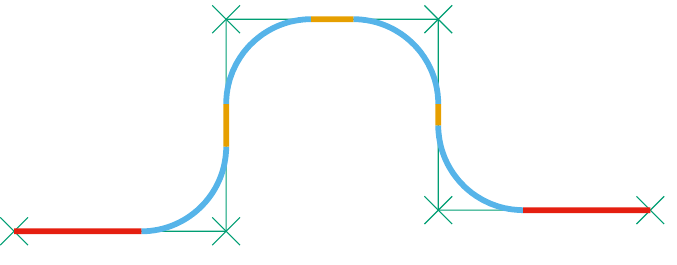
Figure 8. Exemplary rounded polyline.